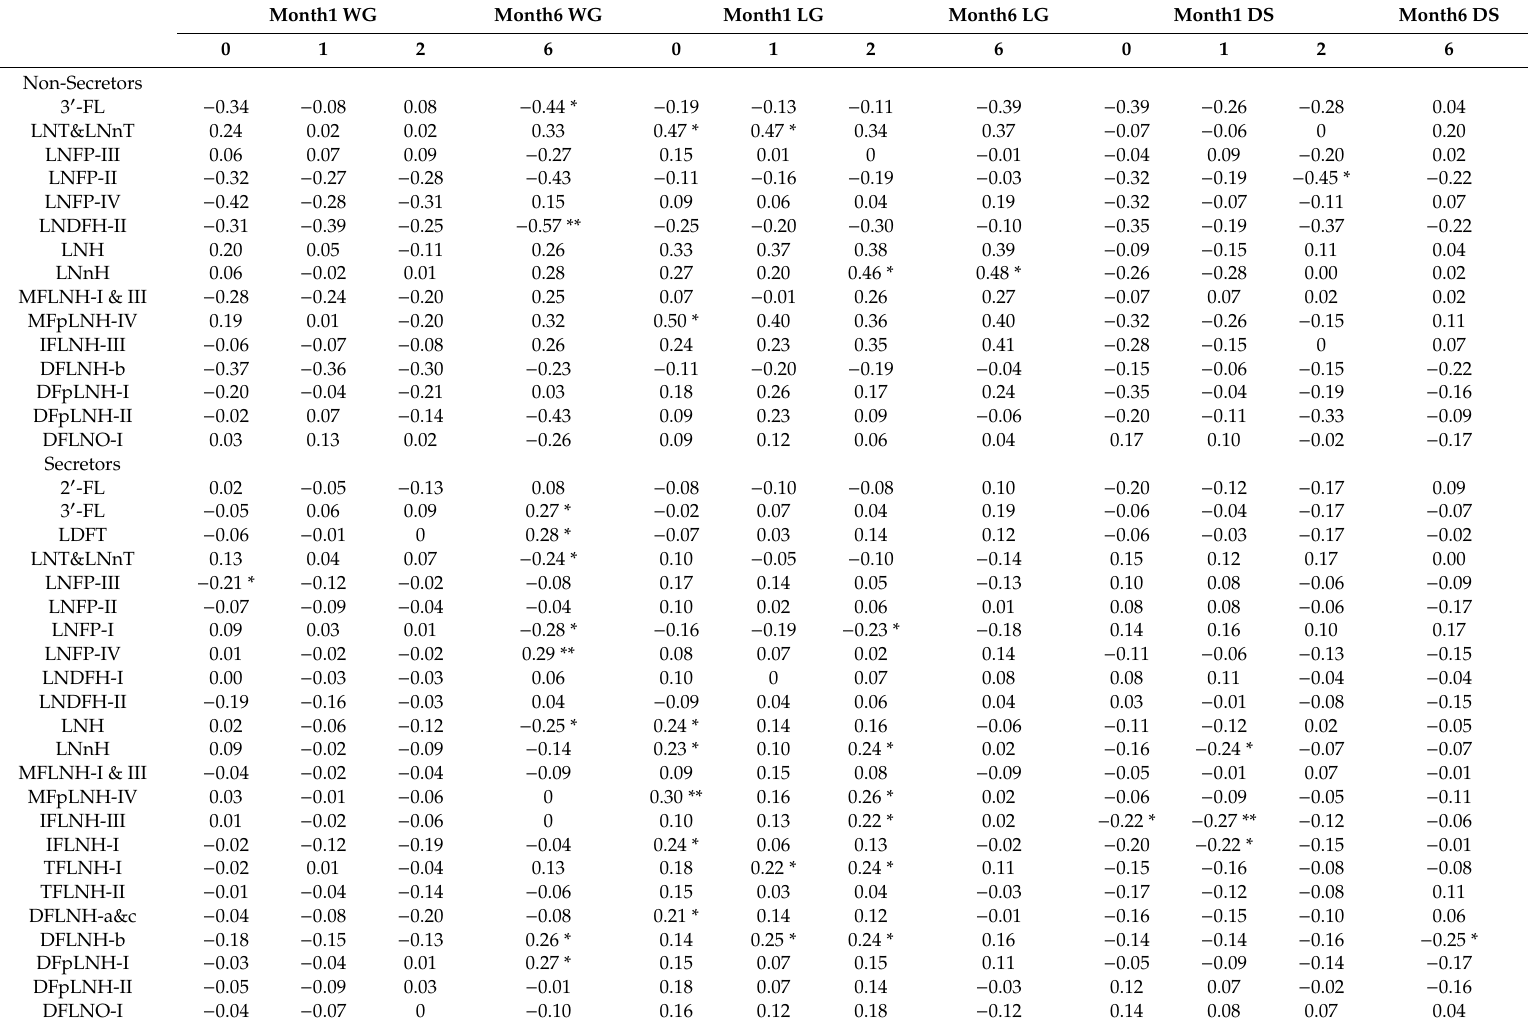
Table 4. Spearman rank correlation coe ffi cient (r) between HMOs concentration and infant growth status and disease